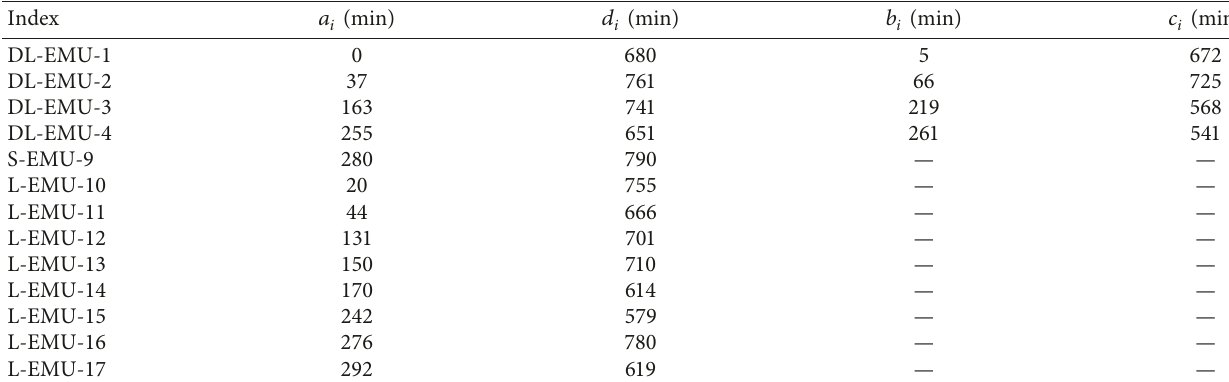
Figure 8: A Gantt chart representation for the optimized shunting plan generated by CPLEX at the stub-end EMU depot. Table 6: The processed schedule including DL-EMUs.